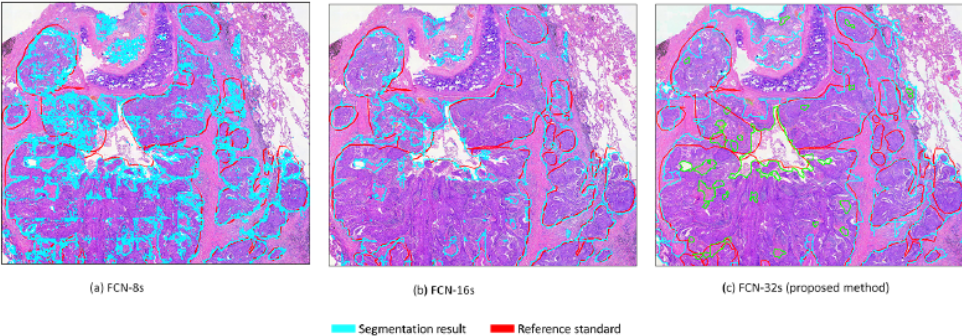
Figure 4. Three upsampling layers are compared. The findings of ( a ) FCN-8s and ( b ) FCN-16s are excessively fragmented when evaluated against the results of the ( c ) FCN-32s, which are the closest to the reference